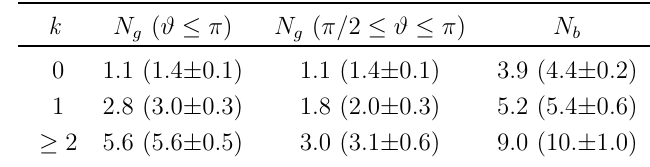
Table 3. The average multiplicity of N g and N b particles associated with a di ff erent number k = 0,1 and k ≥ 2 of final state cumulative protons. The formation time is l f = 0.5 fm / c. The experimental data are given in